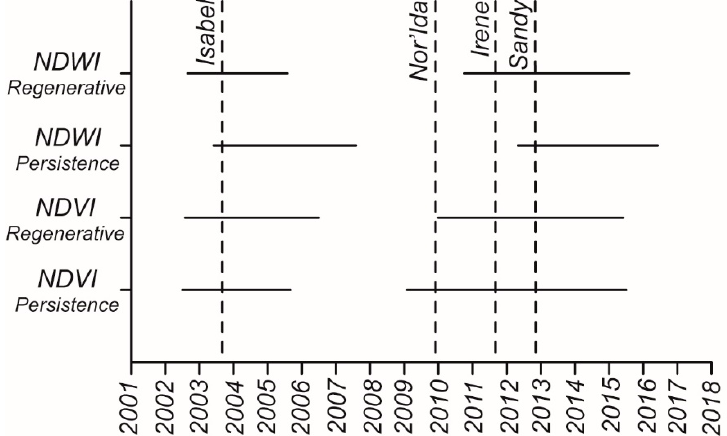
Figure 8. Periods with lower average NDVI and NDWI in the persistence and regenerative zones (negative anomaly of detrended moving average).